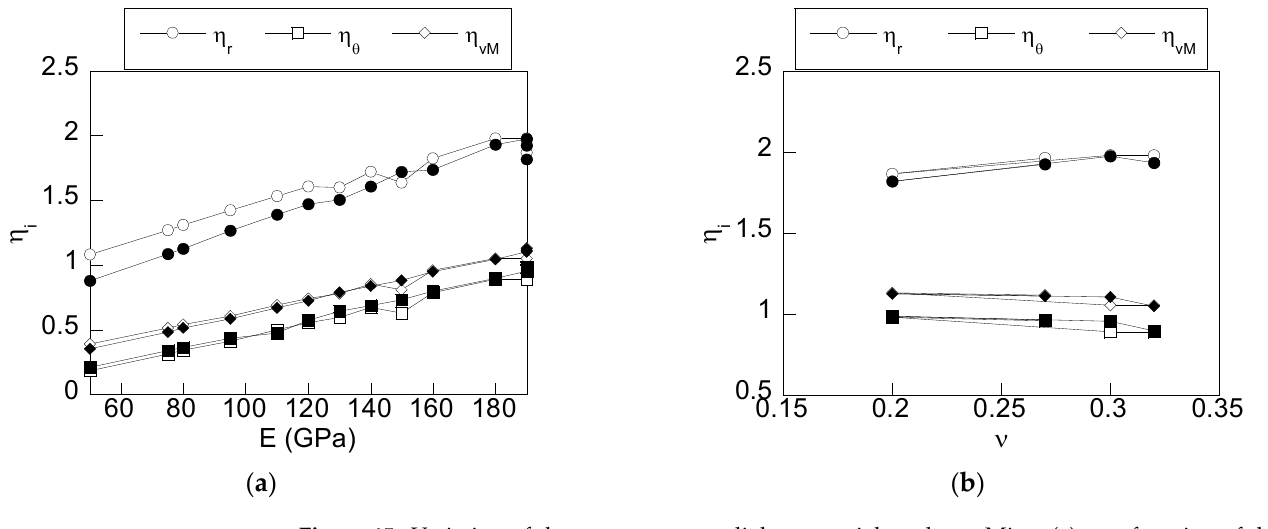
Figure 15. Variation of the parameter η radial, tangential, and von Mises ( a ) as a function of the material Young modulus of the contact ring, and ( b ) against the Poisson coefficient of the material of the contact ring (blank symbols, γ = 0.125 and full symbols, γ = 0.250).